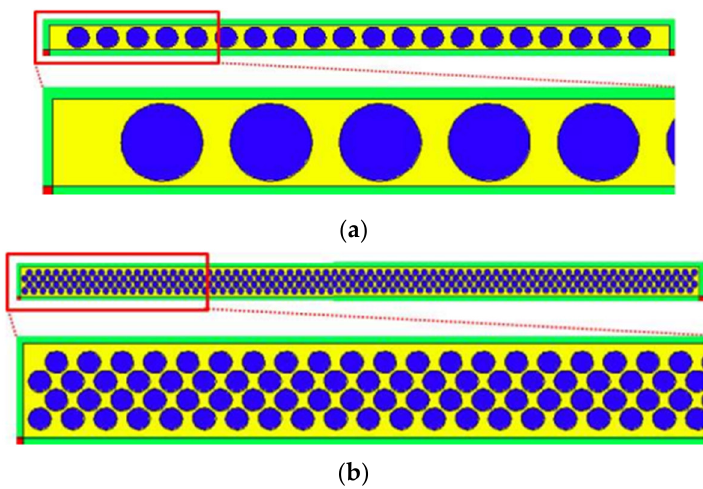
Figure 8. Cross section of thin film type fibrous composites. ( a ) d = 0.1784 cm, ( b ) d = 0.0461 cm.